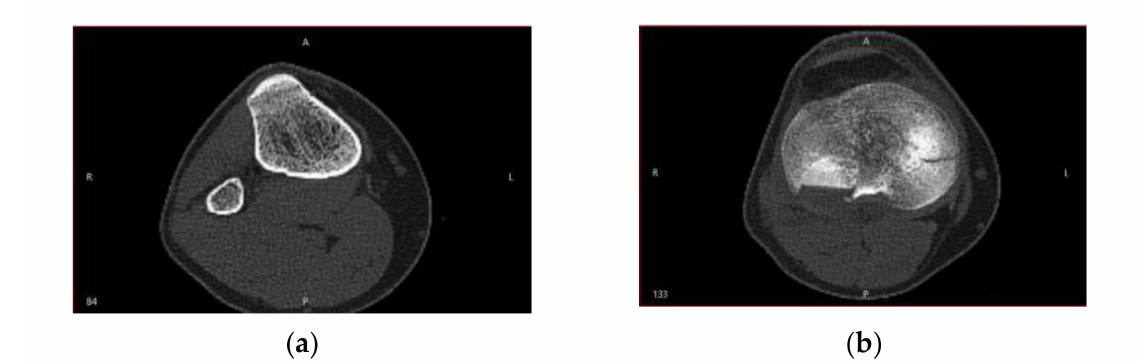
Figure 3. Cortical and cancellous tissue view in a CT: ( a ) high-intensity circular regions show thick cortical bone tissue in the median area of the tibia; ( b ) more proximal, there is much less contrast between the regions of cortical and cancellous bone